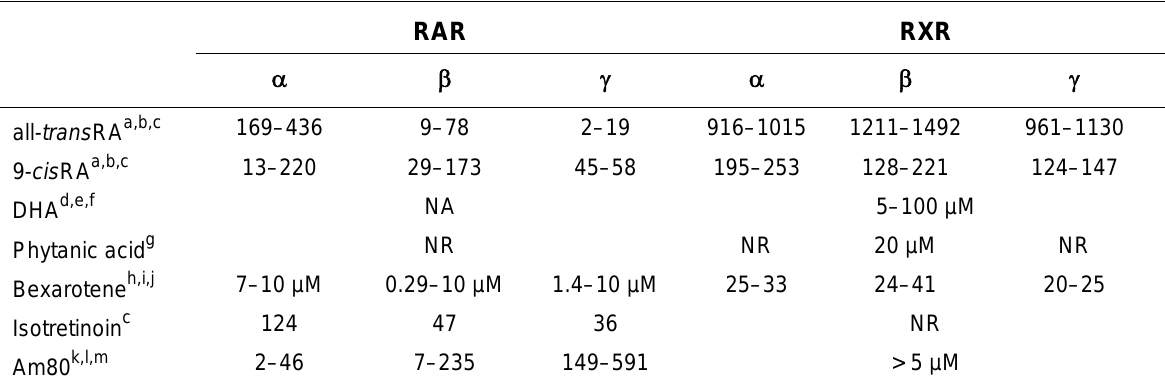
Commonly Used Retinoid Receptor